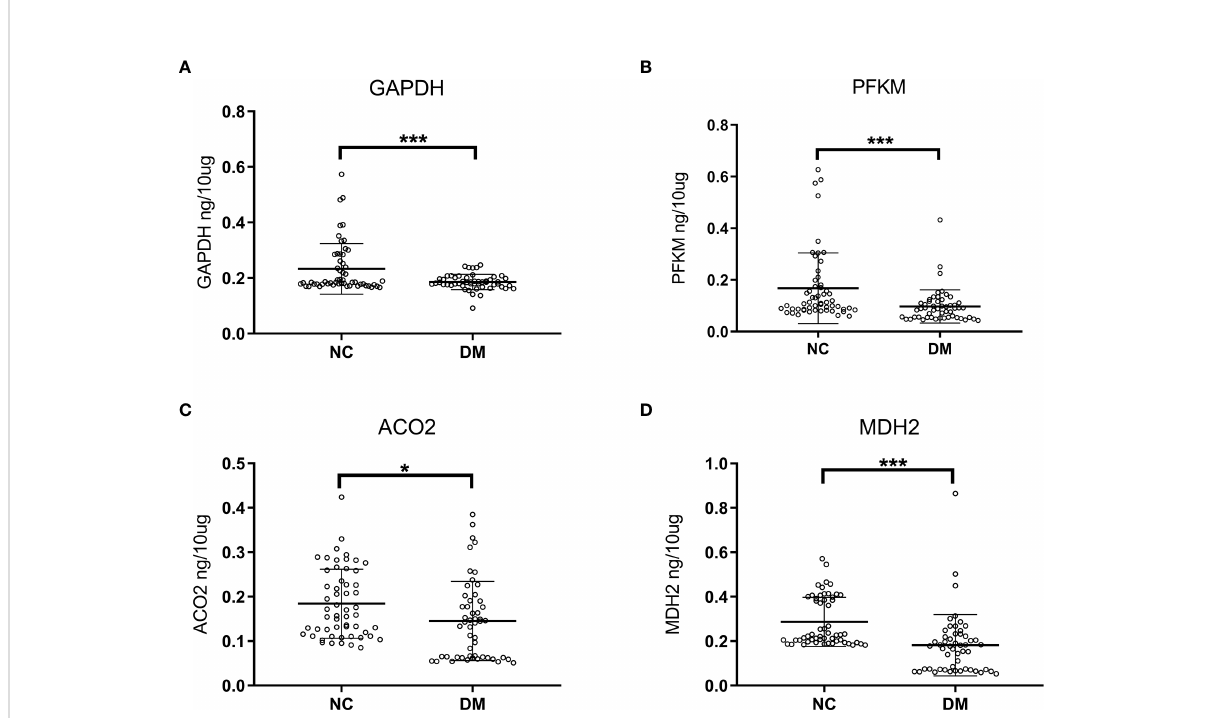
FIGURE 5 Analysis of ELISA results in diabetic group (DM, n=52) and normal controls (NC, n=55). Concentrated expression of GAPDH (A) , PFKM (B) , ACO2 (C) and MDH2 (D) in urinary exosomes was measured by ELISA. The expressions of GAPDH, PFKM, ACO2 and MDH2 in the urine of the diabetic patients were lower than those of the normal control group. The unit is ng/10mg, which represents the target protein content per 10mg total protein. Symbols represent individual subjects, each measured once in an independent experiment, ***, p<0.001; *,